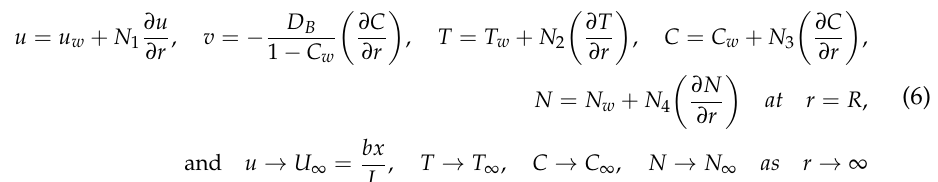
Figure 1. Physical model with co-ordinate system. Here v and u represents radial velocity and horizontal velocity. Additionally, T ∞ stands for ambient temperature, D B stands for Brownian diffusion coefficient, λ E denoted the thermal relaxation parameter, T stands for temperature, λ C stands for nanoparticle volume fraction relaxation parameter, D T stands for thermophoresis diffusion coefficient, K r is the chemical reaction parameter, C stands for nanoparticle volume fraction, B 0 stands for magnetic field intensity, σ hnf stands for electrical conductivity, ν hnf stands for kinematic viscosity and U ∞ stands for free stream velocity. In Equation (5), d is constant, W c is maximum swimming speed of micro-organisms in hybrid-nanofluid and D N is diffusivity of